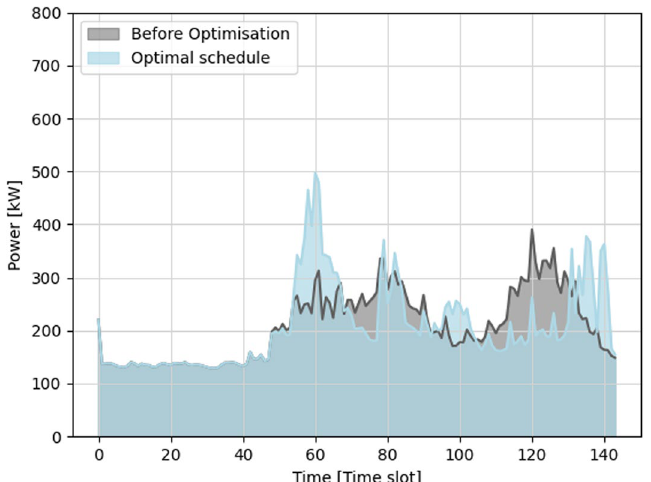
Fig. 7 Example of optimal scheduling for 2000 households in Case study 1 with ± 3 h of shift allowed